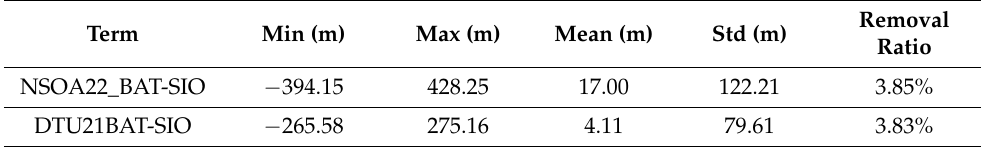
Table 5. Statistics on the differences between the NSOAS22_BAT and SIO V19.1